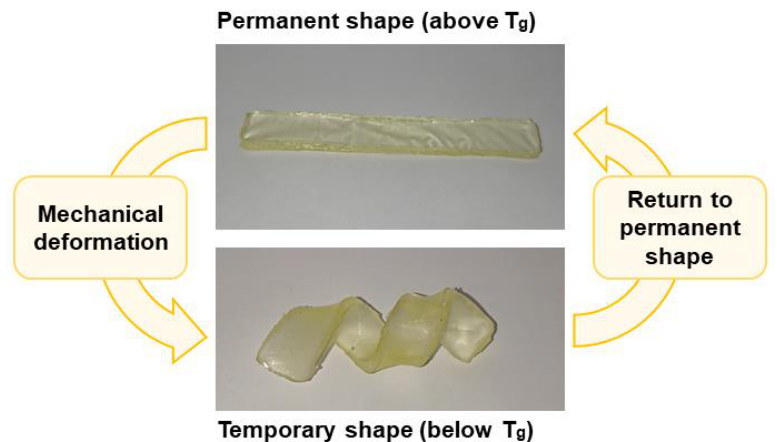
Figure 7. Shape-memory properties of polymer samples.